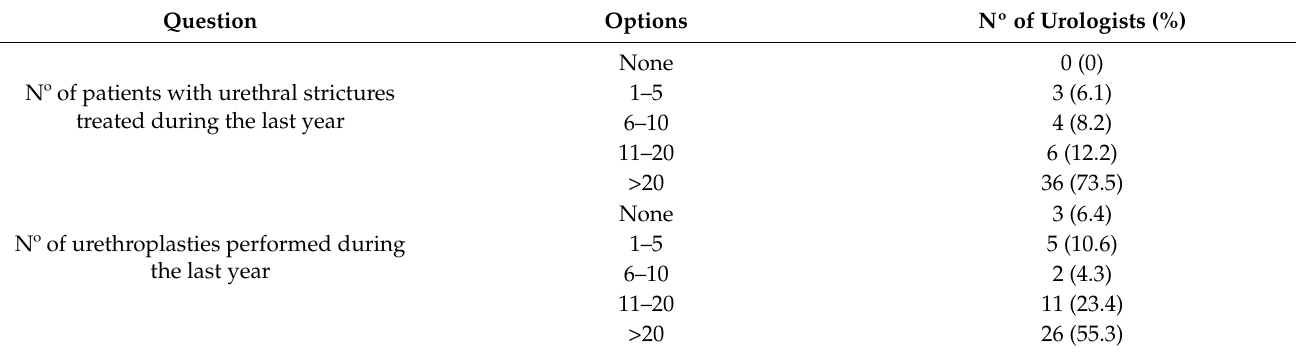
Table 3. Number of urethral stricture patients and urethroplasties performed last